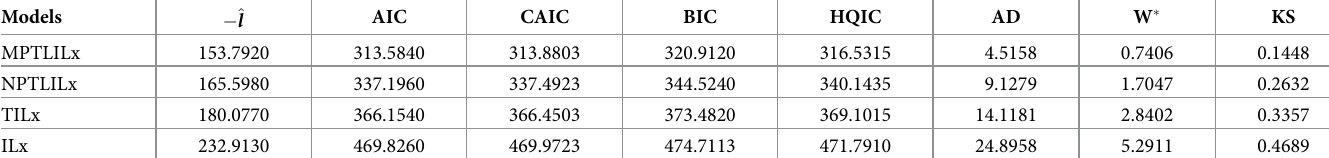
Table 4. The information criteria results for the hailing time data. Models